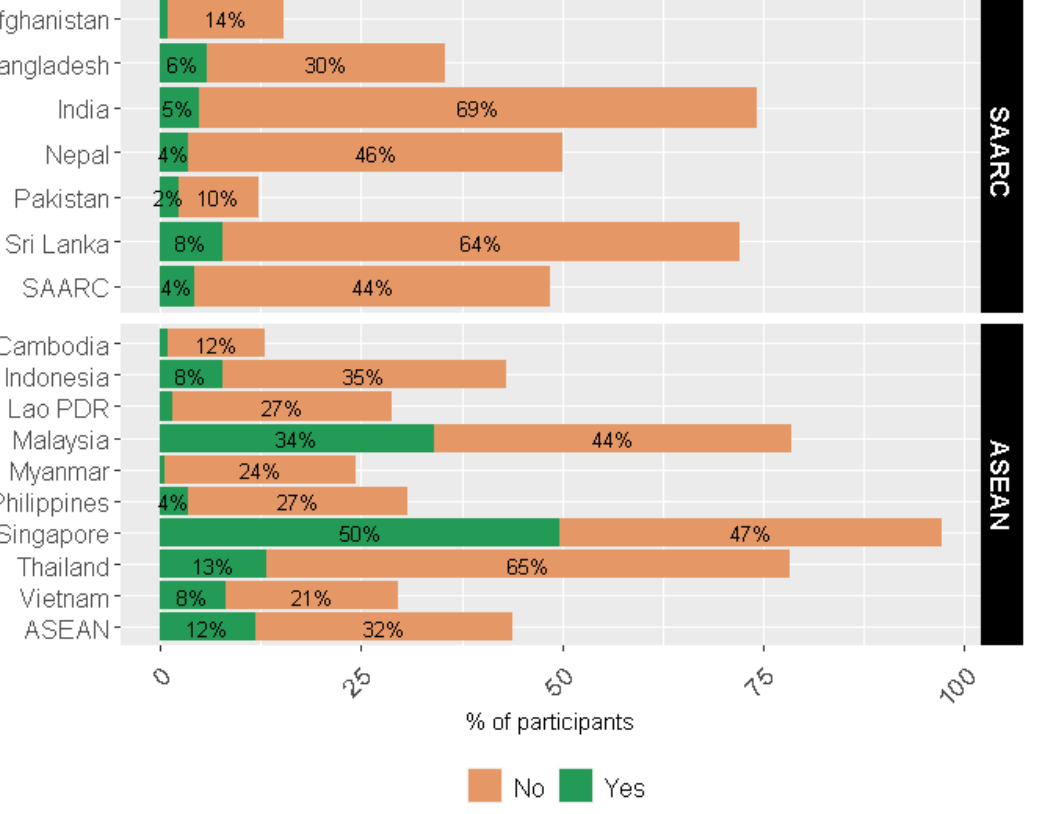
Figure 3. Percentage of participants who used a mobile phone or the internet for payment, purchase, or cash transactions.